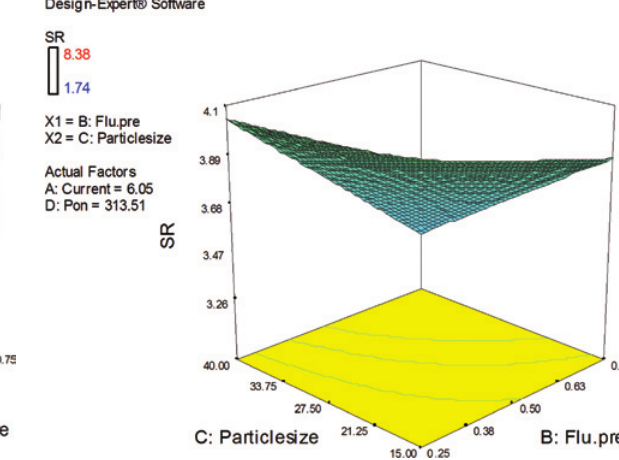
Figure 8 Interactive effect of flushing pressure and particle size on EWR.